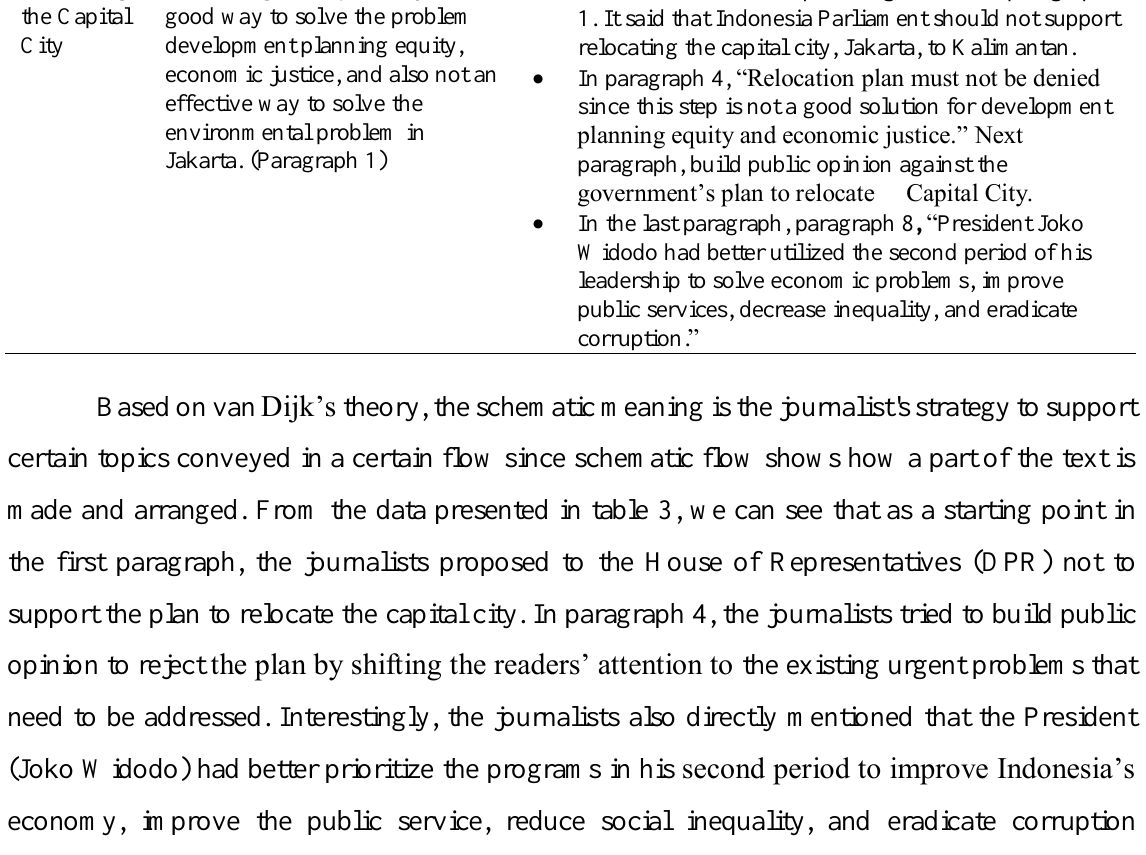
Table 3. Superstructure (Schematic)